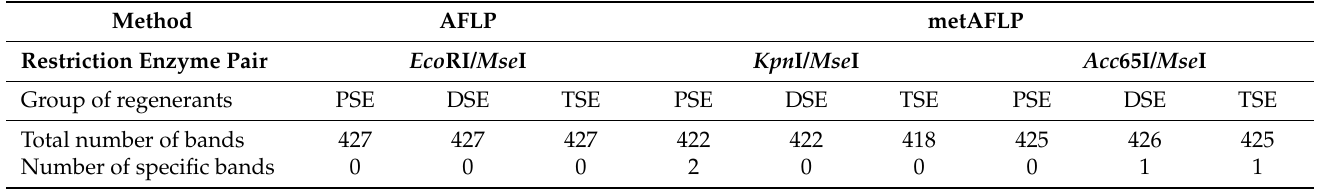
Table 3. Number of specific bands identified between three groups of regenerants using the AFLP and metAFLP methods.